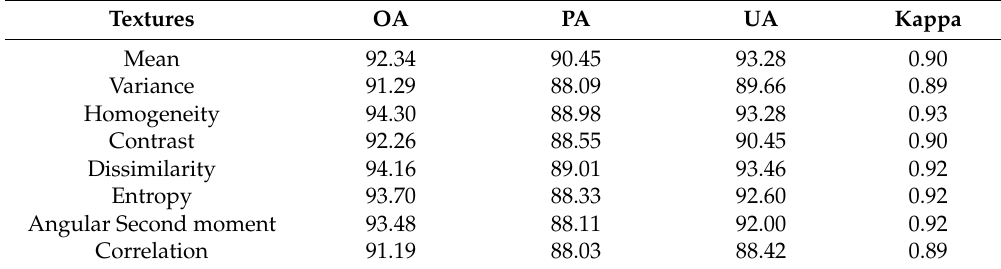
Table 7. The accuracy from combined spectral and each textural feature of the NIR bands.